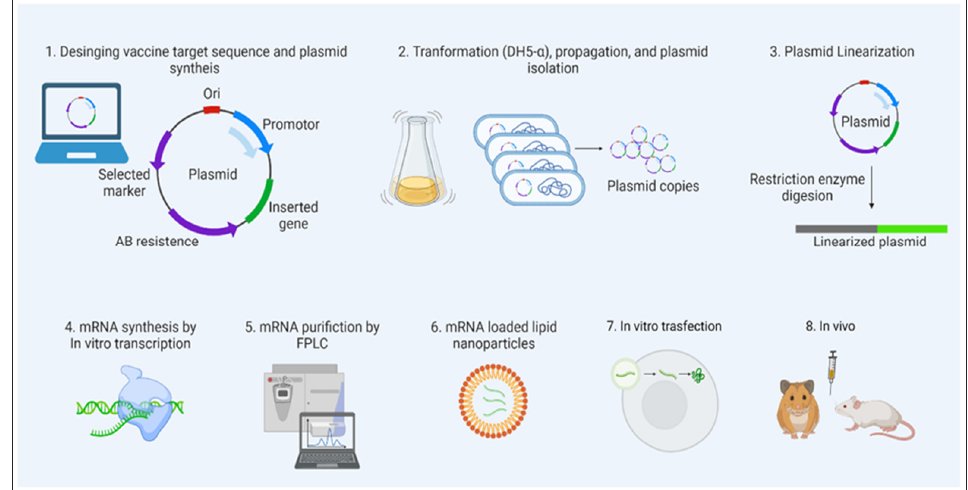
Figure 6. mRNA vaccine development. The figure illustrates the sequential steps involved in the mRNA vaccine development, from design to preclinical studies. Prior to going on to the next step, quality evaluation is required at each step. Table 2. FDA approved COVID-19 mRNA vaccines